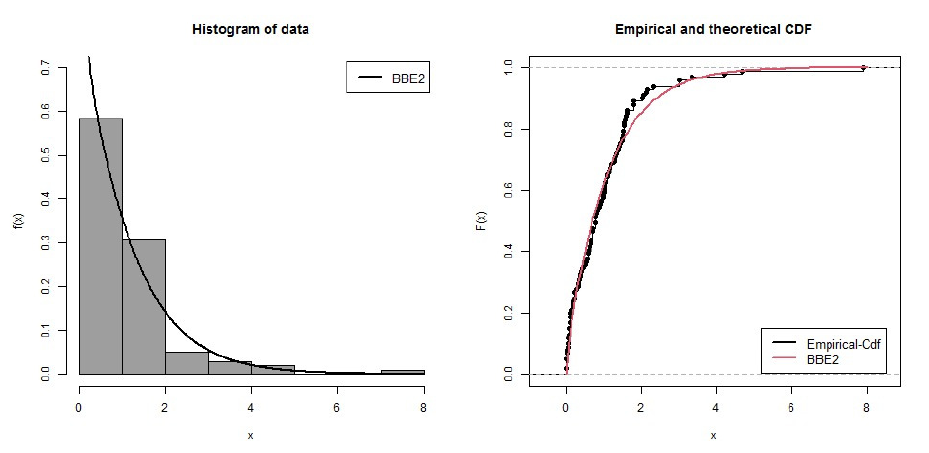
Figure 3. Plots of the epdf and ecdf for the BBE 2